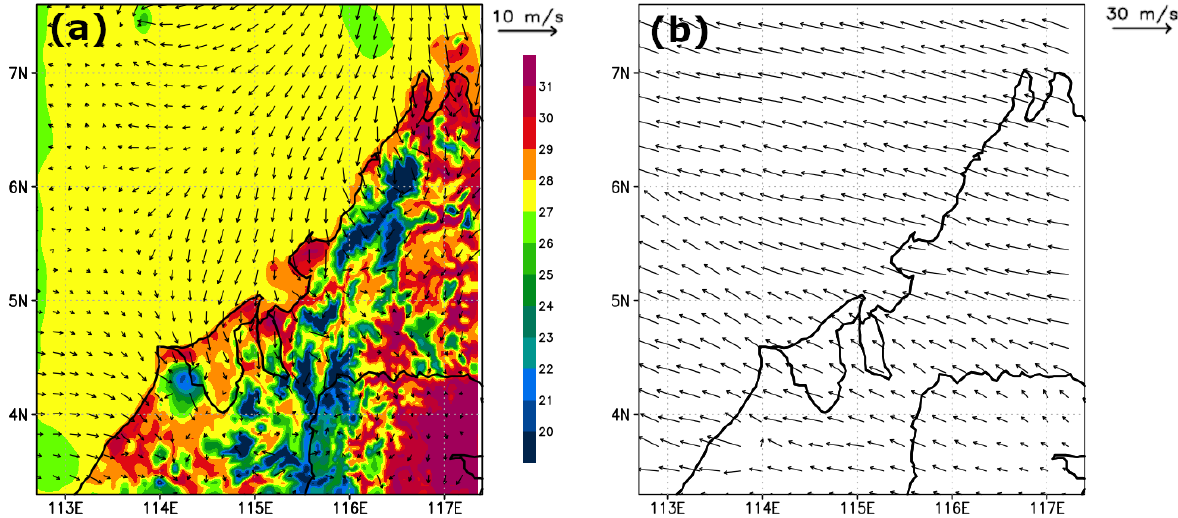
Figure 5. Simulated (a) temperature and horizontal wind at the lowest model level (24m) at 06:00UTC. (b) Horizontal wind at 11700m altitude at 09:00UTC from the C-CATT-BRAMS model. The vertical axis is latitude (degrees north), and the horizontal axis is longitude (degrees east). Table 2. Characteristics of the observed and simulated deep convective systems. The cloud top heights for the observed convective systems are based on Hamada and Nishi (2010) and Iwasaki et al. (2010). The outflow refers to the stratiform part of the convective system. Location where the Time when the con- Time when the outflow starts Estimated maximum top altitude of the out- convective system first vective system first to dissipate flow reaches ∼ 14 . 5km reaches ∼ 14 . 5km altitude altitude